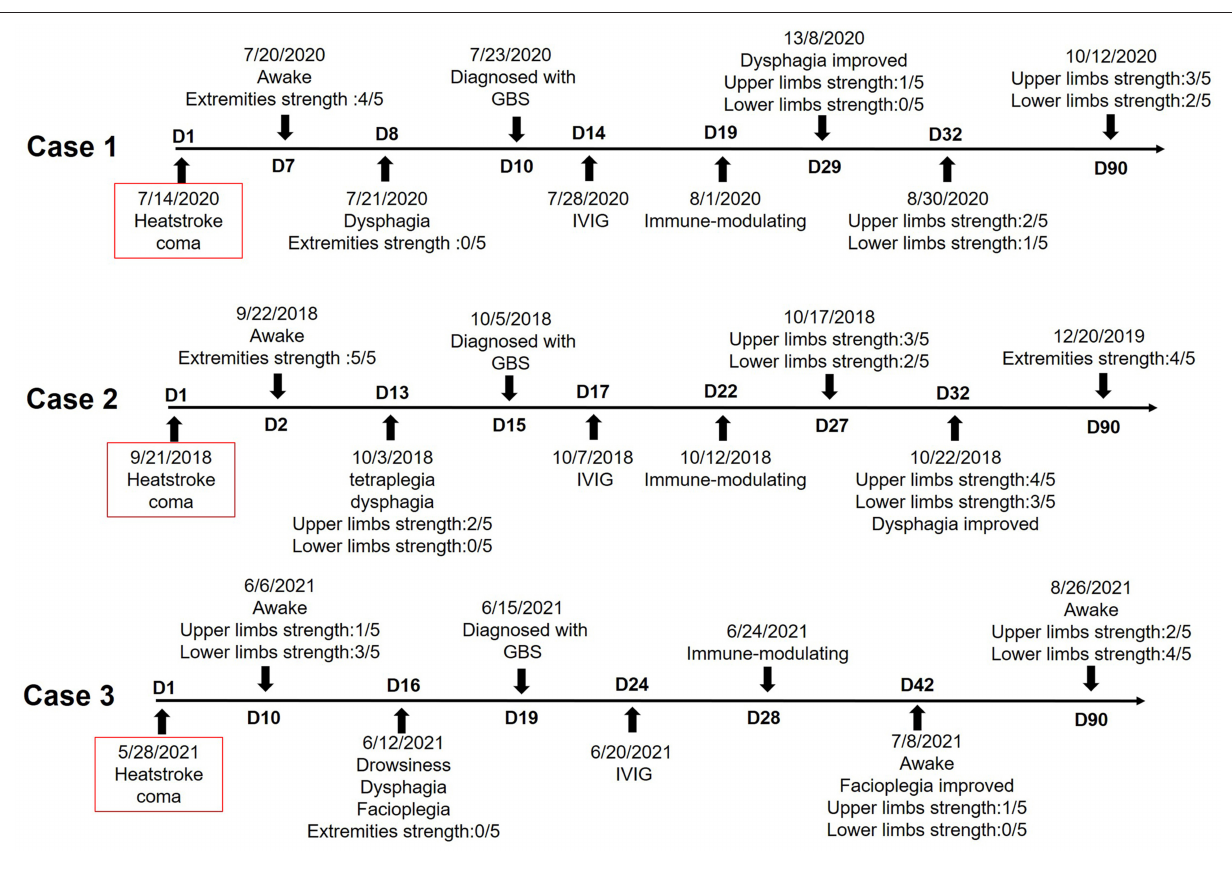
FIGURE 2 | The timeline of the disease and treatment of these three patients with GBS induced by